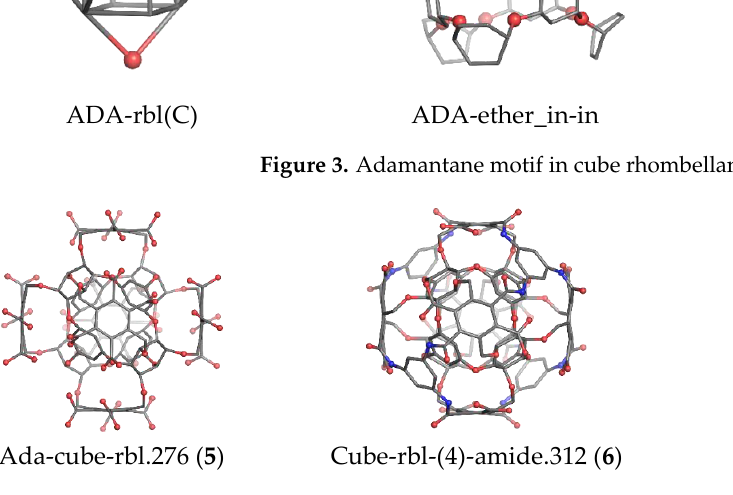
Figure 4. Cube-rhombellanes.